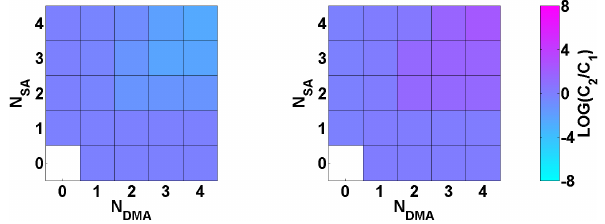
Fig. 8. The differences in cluster concentrations when the coagula- tion coefficient is increased by a factor of 10 (left panel) or turned off (right panel). The colour scale gives the base-10 logarithm of the ratio of the concentrations when compared to the standard con- ditions.